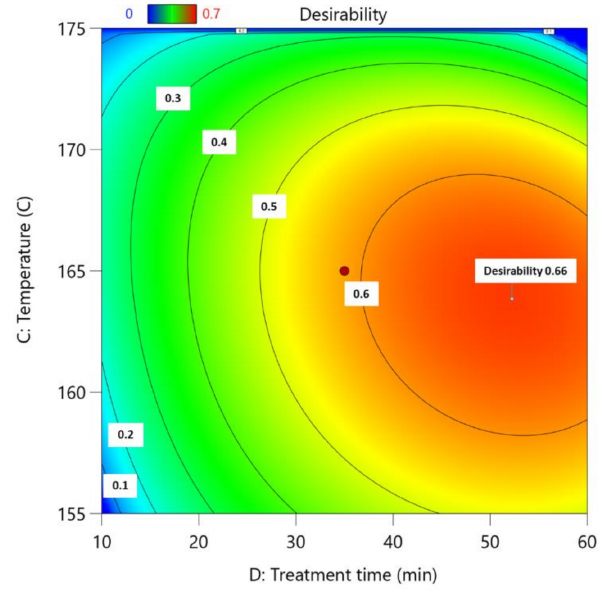
Figure 8. Influence of process time and temperature on total desirability of process; the actual factors for the regression model are A = 85 and B =